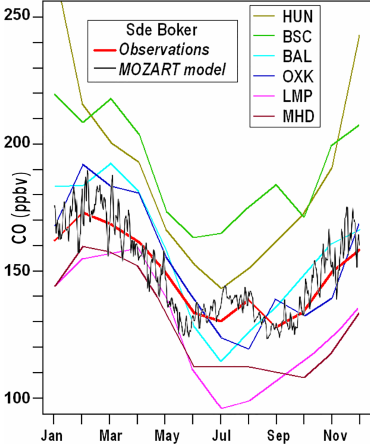
Figure 19. Monthly mean CO concentrations over 1996–2009 at Sde Boker (red) and at seven European ESRL/GMD background stations (listed in Table 3, multiple colors), compared to the 5- year averaged CO surface concentrations at Sde Boker (black) over 2003–2007 from the MOZART-4 chemistry-transport model (adapted from Drori et al.,